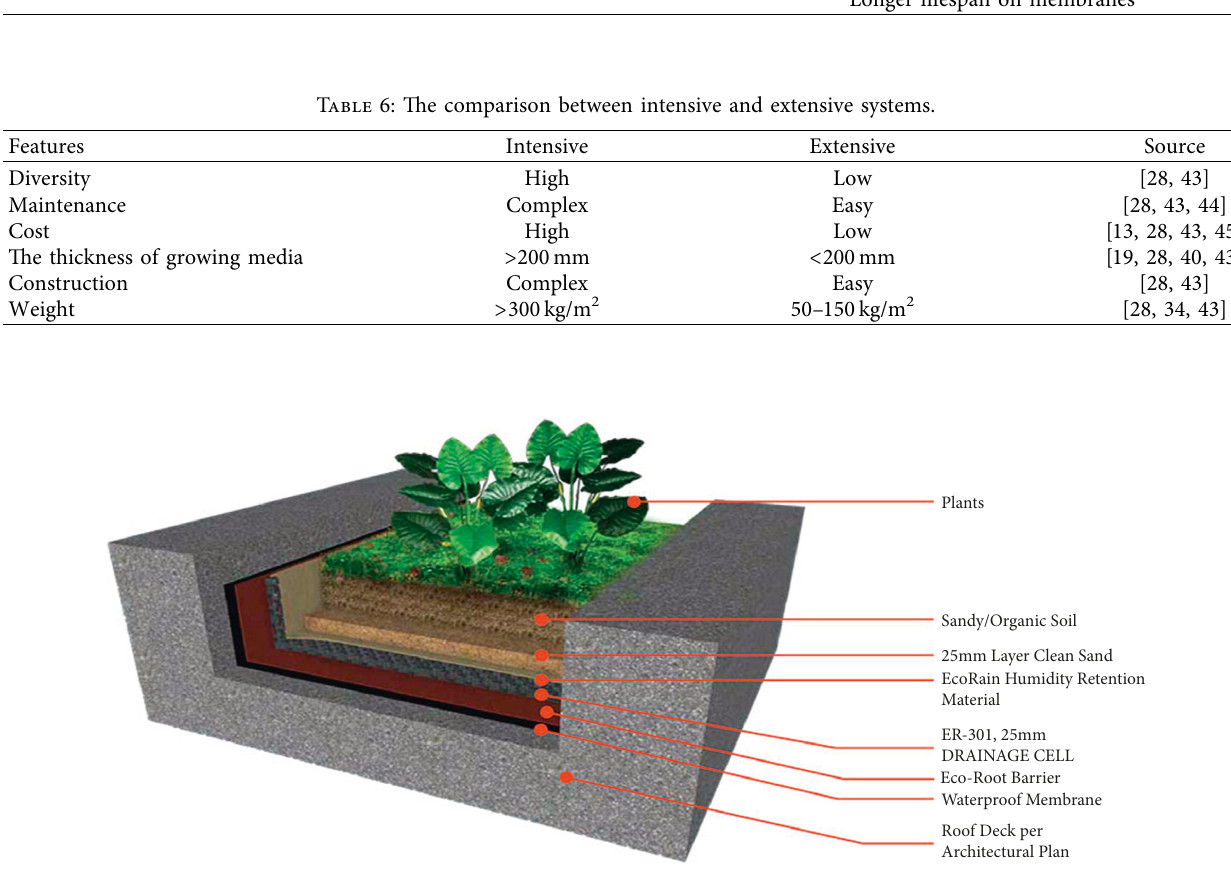
Figure 3: Green roof system [38].